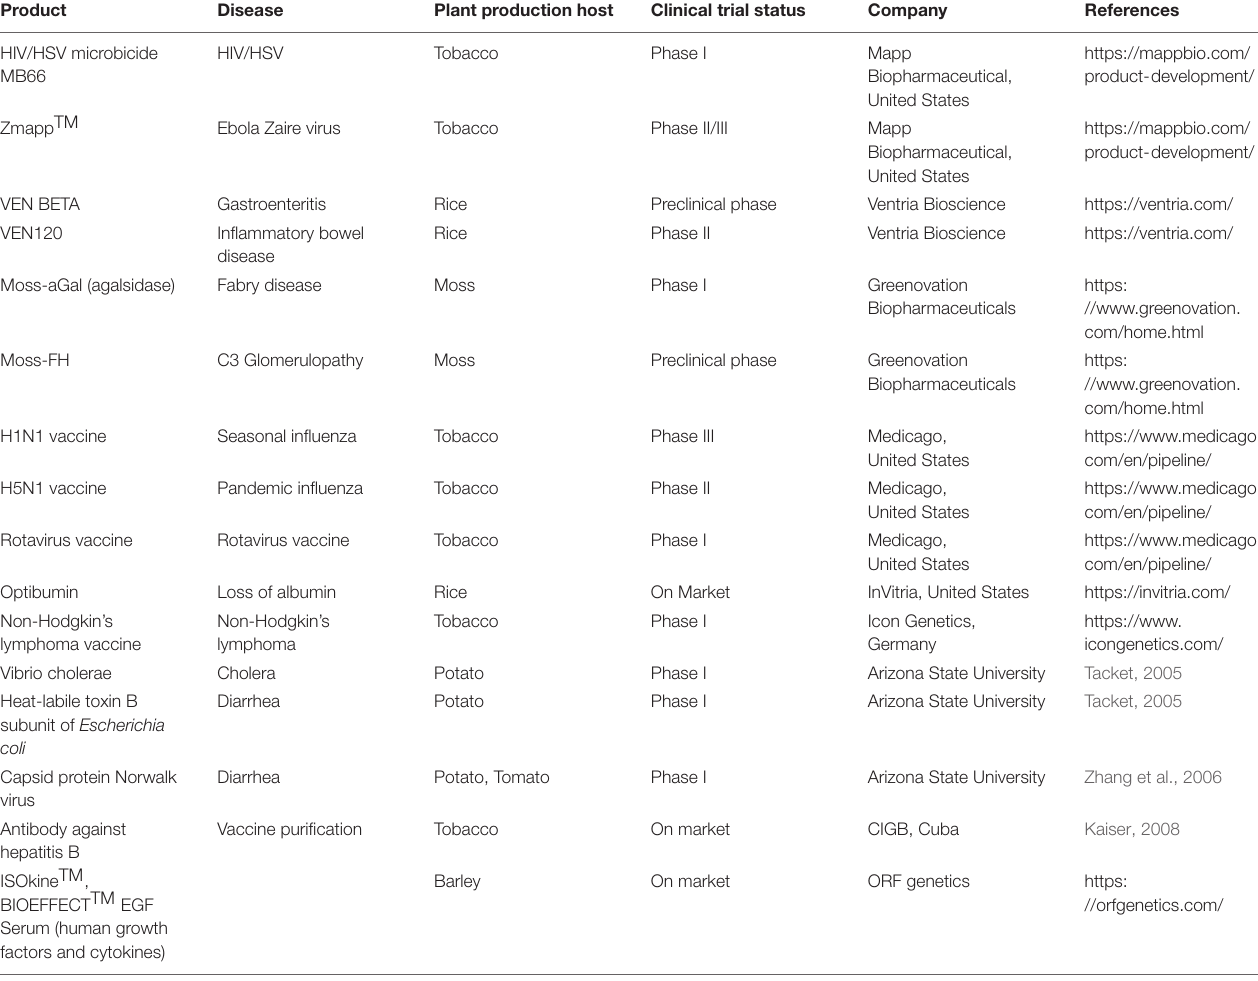
TABLE 1 | Examples of plant made pharmaceuticals.